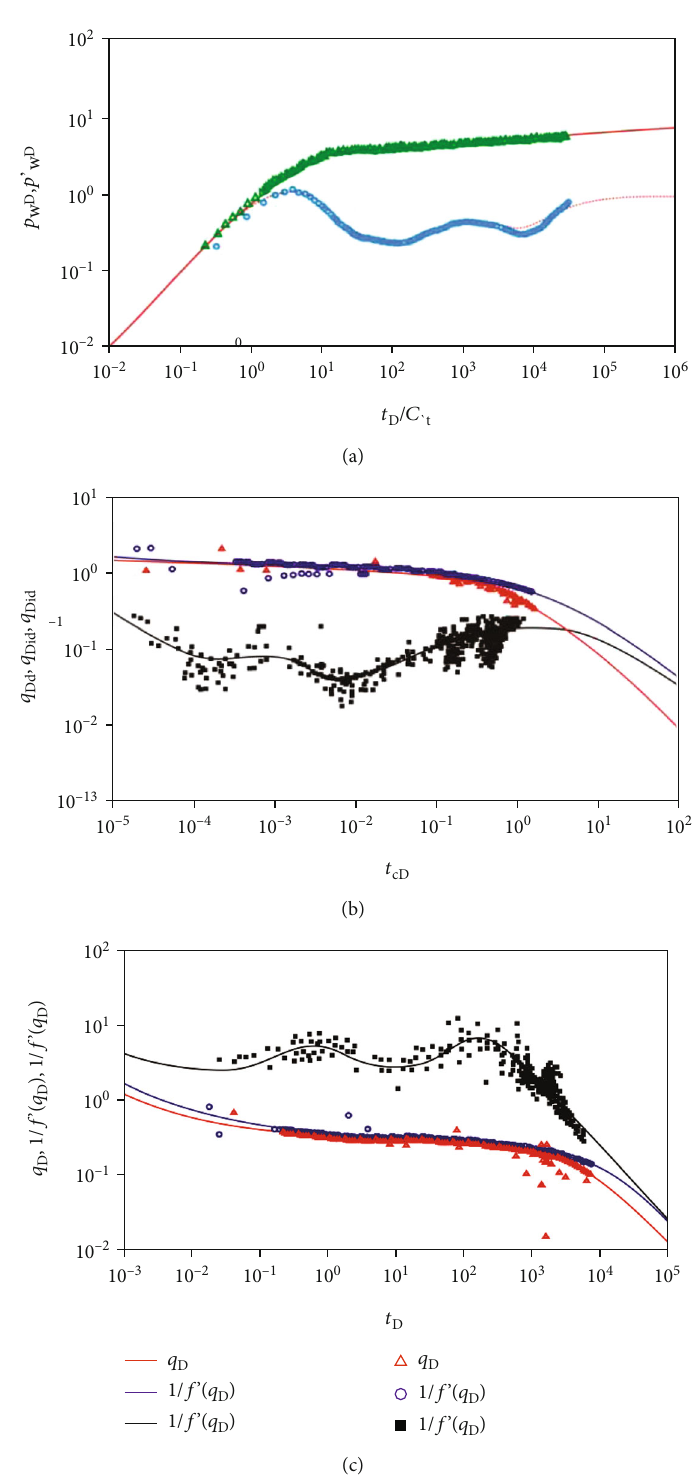
Figure 16: Matching curves for fi eld case 2: (a) well test analysis; (b) Blasingame type curve analysis; (c) new type curve